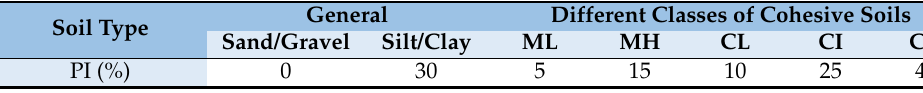
Table 2. Recommended PI values for different soil types.